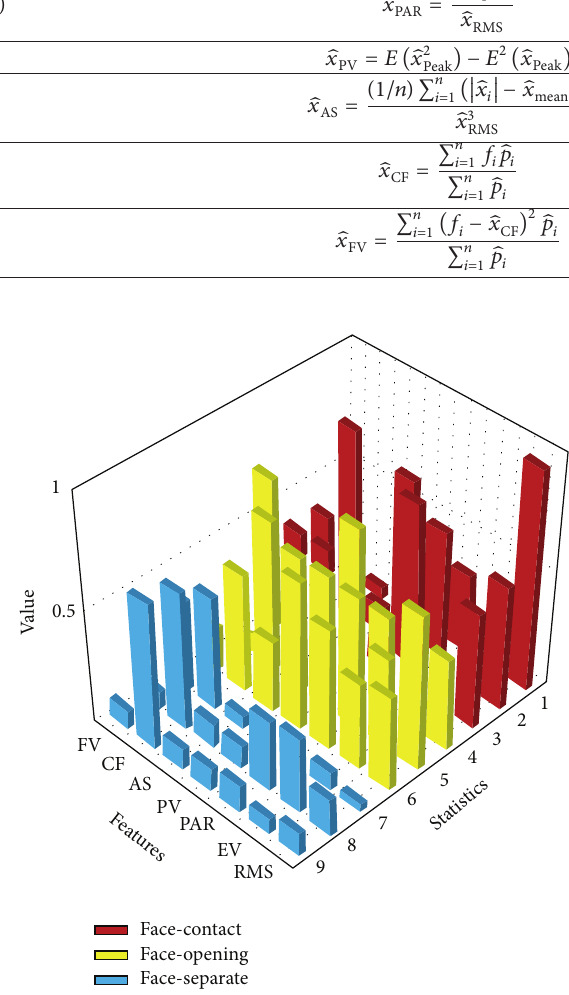
Figure 9: Histogram of sample